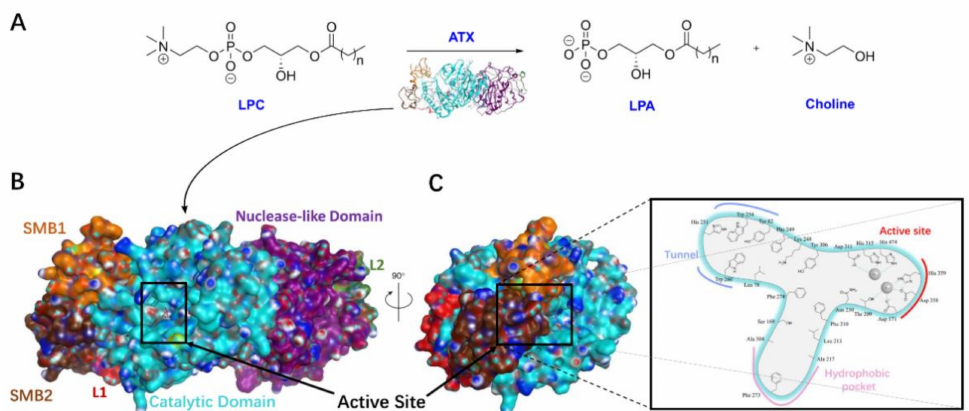
Figure 1. Conversion of LPC into LPA by ATX and overall structure of ATX. ( A ). ATX hydrolyzes lysophosphatidylcholine (LPC) to lysophosphatidic acid (LPA). ( B ). Surface representation of the ATX structure and domains (ID 2XR9). Somatomedin B-like domain 1 (SMB1) in orange; SMB2 in brown; Catalytic Domain in cyan; Nuclease-like Domain in violet; L1 in red; L2 in green. ( C ). The key residues and tripartite interacting site in the T-shaped binding pocket of